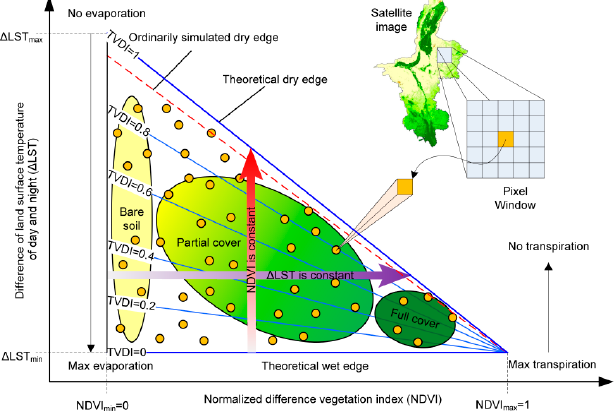
Figure 2. Physical interpretation of the ∆ LST/NDVI feature space and the definition of TVDI (adapted from [17,18]).